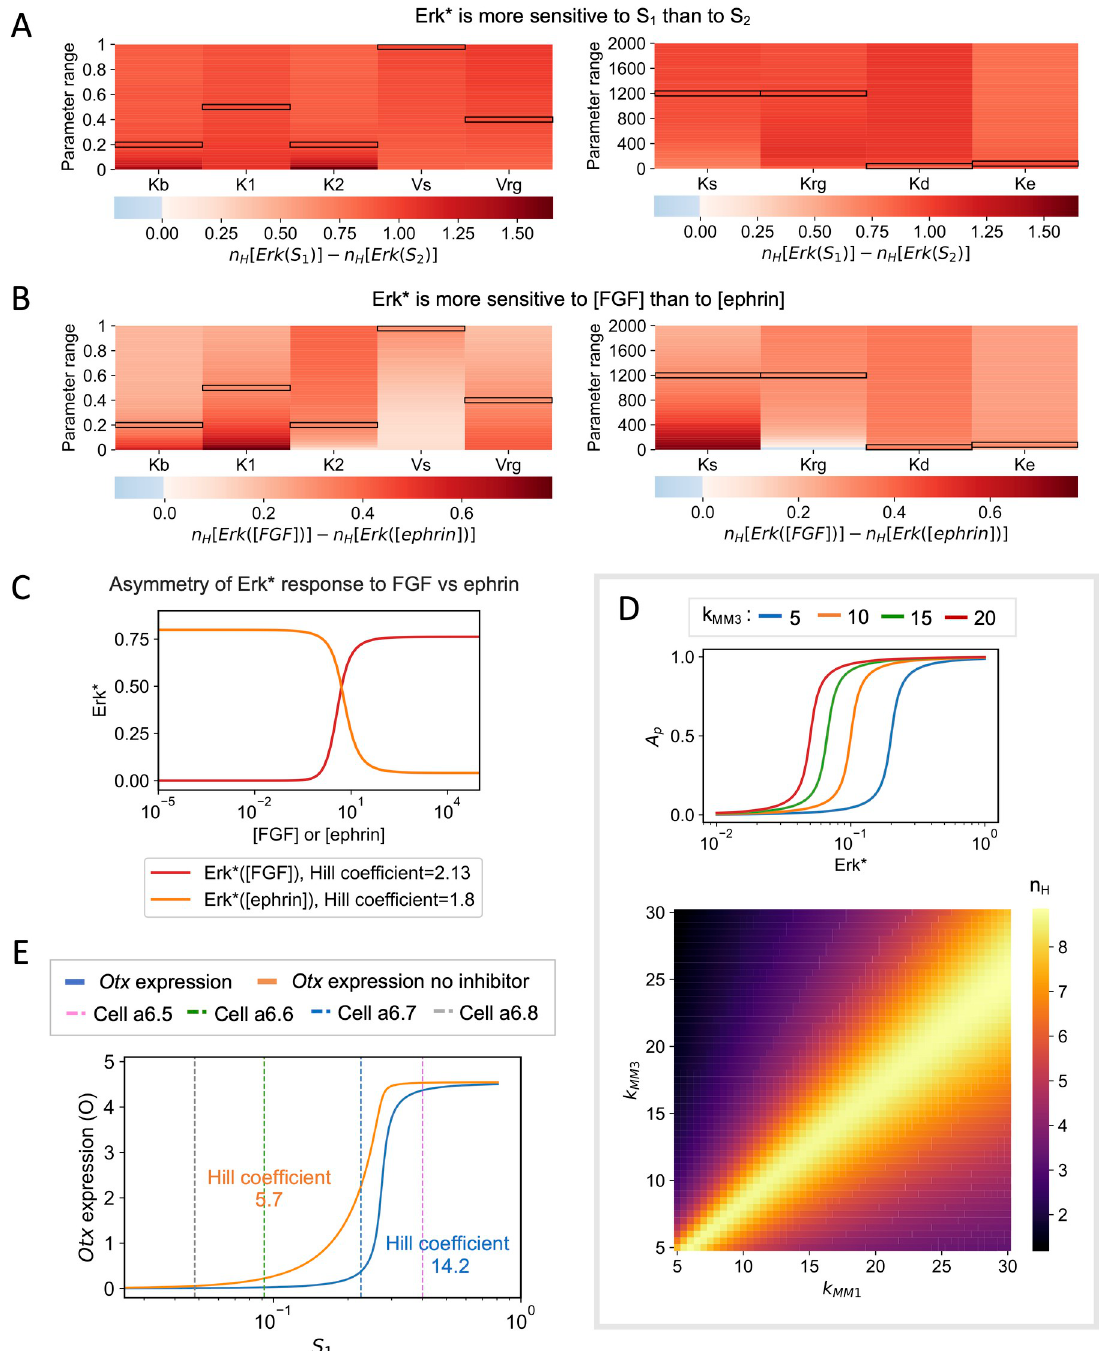
Fig 6. Model prediction. (A) Erk � values are more sensitive to S 1 than to S 2 . Heatmaps show the difference between the Hill coefficient of the curve Erk � (S 1 ) and the Hill coefficient of the curve Erk � (S 2 ). Erk � (S 1 ) was obtained by fixing the value of S 2 = S � (S � = 0.3) and letting S 1 vary between 0 and 1-S � . The same procedure was used to compute Erk � (S 2 ). The Hill coefficients obtained with standard values of the parameters are 1.99 and 1.04 for Erk � (S 1 ) and Erk � (S 2 ), respectively. (B) Erk � values are more sensitive to [FGF] than to [ephrin]. Heatmaps show the difference between the Hill coefficient of the curve Erk � ([FGF]) and the Hill coefficient of the curve Erk � ([ephrin]). To compute Erk � ([FGF]) and Erk � ([ephrin]) we fixed the value of S 1 = 0.3. The standard values of the parameters are highlighted with black boxes. (C) ERK activation levels (Erk � ) shown as a function of FGF concentration (in red) or ephrin concentration (in orange). Values of the parameters used: V s = V rg = 1, K 1 = K 2 = 0.5, K rg = K s = 1200, [FGF] or [ephrin] = 5, K d = K e = 25, R T = Q T = 2000, S 1 = S 2 = 0.5, K b = 10 − 6 . Values of the Hill coefficients were obtained by curve fitting. (D) Upper panel: Effect of changing the k MM3 in Eq (16)